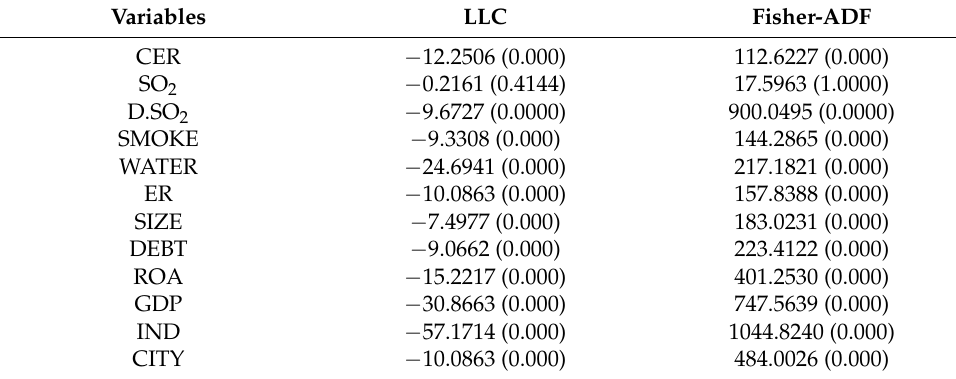
Table 4. Panel unit root test.